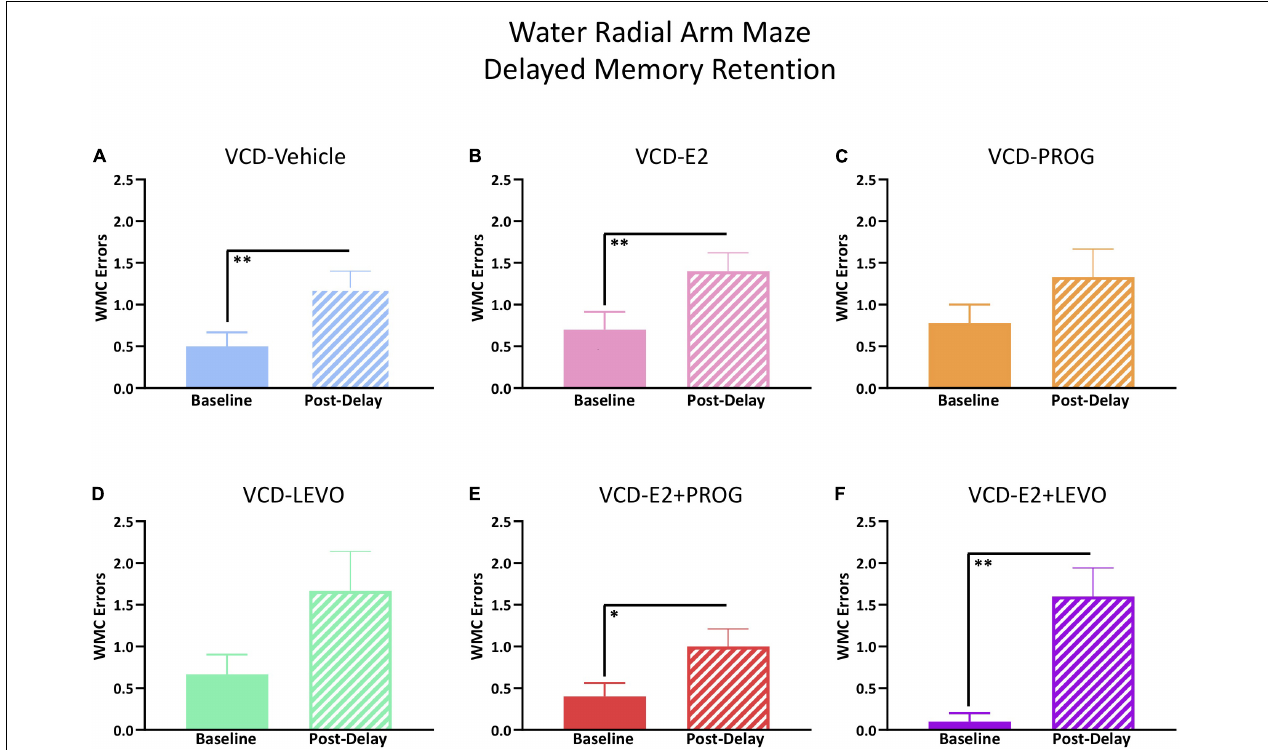
FIGURE 7 | WRAM Six-Hour Delayed Memory Retention Test. (A) The VCD-Vehicle group exhibited a delay-induced working memory impairment compared to the previous day’s baseline performance ( p < 0.01). (B) The VCD-E2 group exhibited a delay-induced working memory impairment compared to the previous day’s baseline performance ( p < 0.01). (C) The VCD-PROG group did not display a delay-induced working memory impairment compared to the previous day’s baseline performance. (D) The VCD-LEVO group did not display a delay-induced working memory impairment compared to the previous day’s baseline performance. (E) The VCD-E2 + PROG group exhibited a delay-induced working memory impairment compared to the previous day’s baseline performance ( p < 0.05). (F) The VCD-E2 + LEVO group exhibited a delay-induced working memory impairment compared to the previous day’s baseline performance ( p < 0.01). Significance: ∗ = p < 0.05, ∗∗ = p <